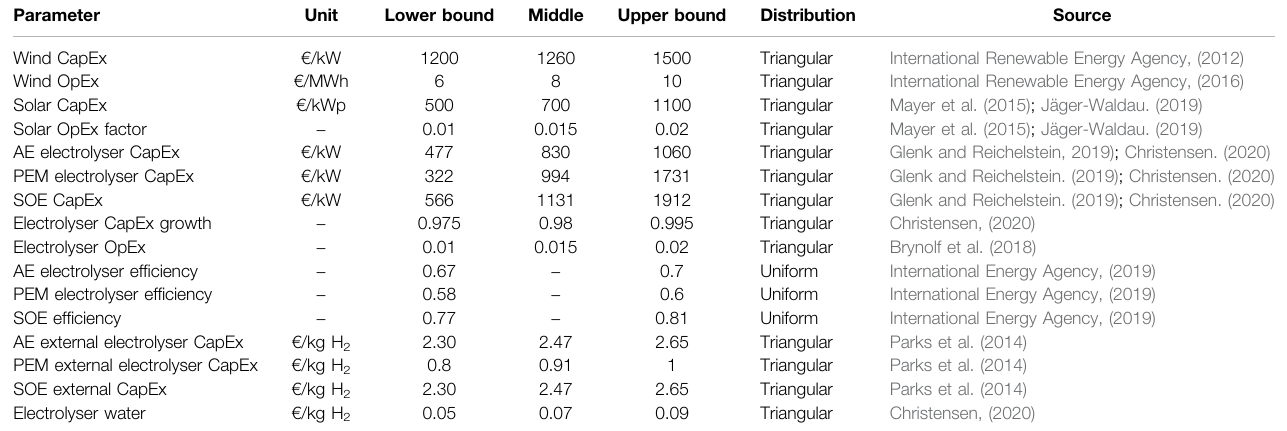
TABLE 1 | Parameters and distributions used in Monte-Carlo simulation of the production cost of H 2 from electrolysis in 2020.